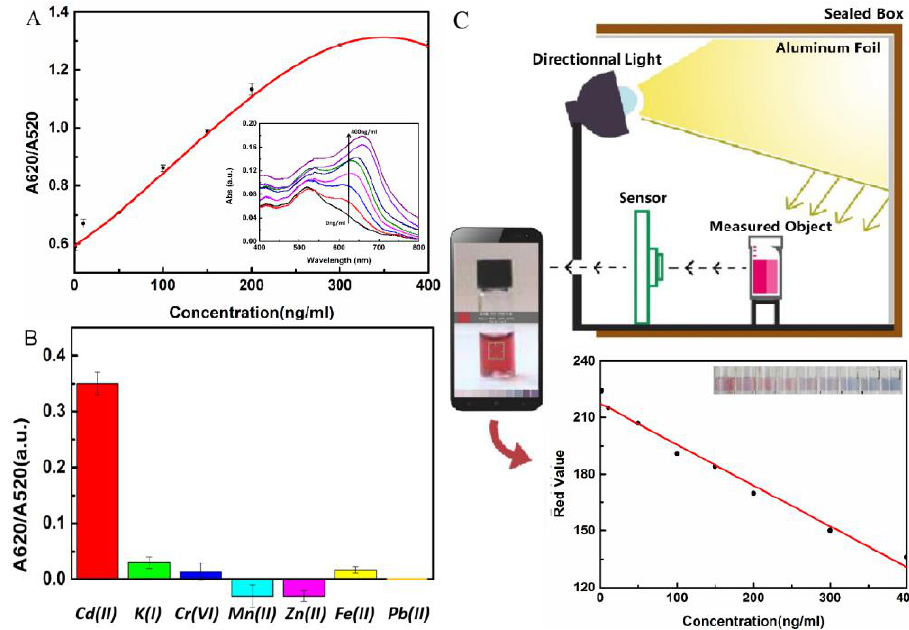
Figure 4. The standard curve and selectivity of the aptamer/nanogold-based colorimetric assay for detection of Cd(II). ( A ) The standard curve with different concentrations of Cd(II) using the proposed colorimetric method with UV−vis spectra. ( B ) Selectivity of the colorimetric detection of Cd(II). ( C ) Schematic illustration and the standard curve with different concentrations of Cd(II) using the proposed colorimetric method combined with a smartphone.